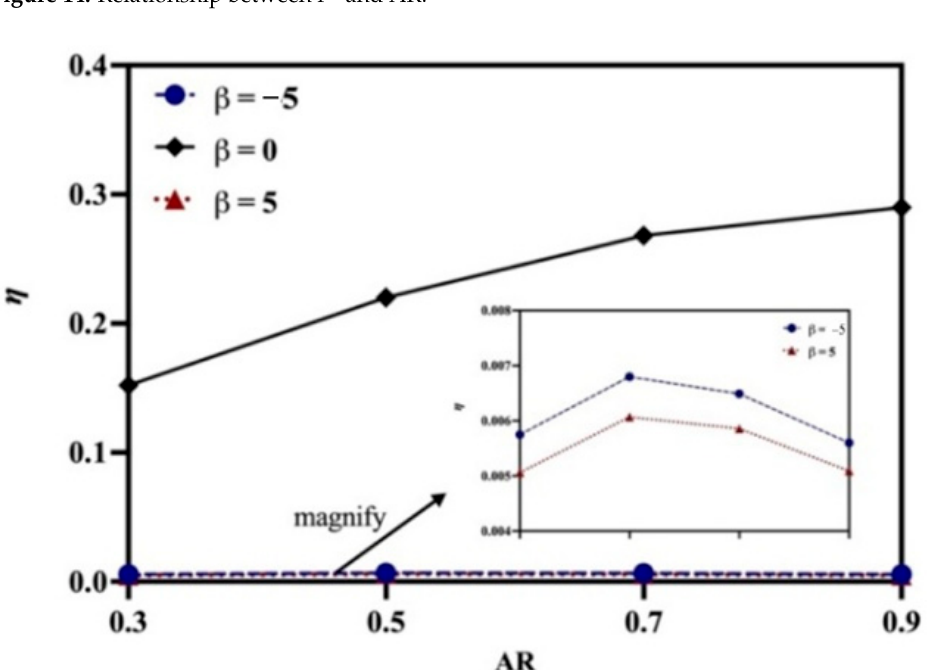
Figure 15. Relationship between η and